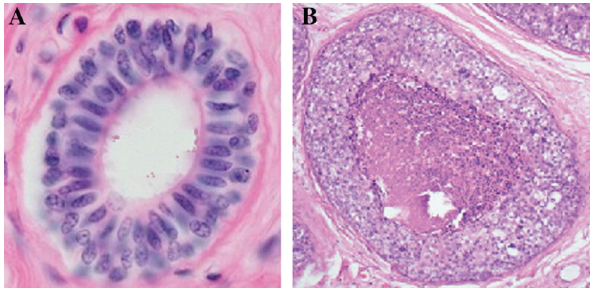
Figure 2: Normal histological structure (A) of a duct in the human breast, in cross section. The double layer of cells is visible. The innermost layer (elongated nucleus cells) define the luminal epithelium, and are surrounded by myoepithelial cells (rounded nucleus cells). The entire structure is surrounded by a basal membrane (in pink). In (B), a DCIS structure, where the light of the duct is invaded by cells that have undergone a neoplastic transfor- mation.